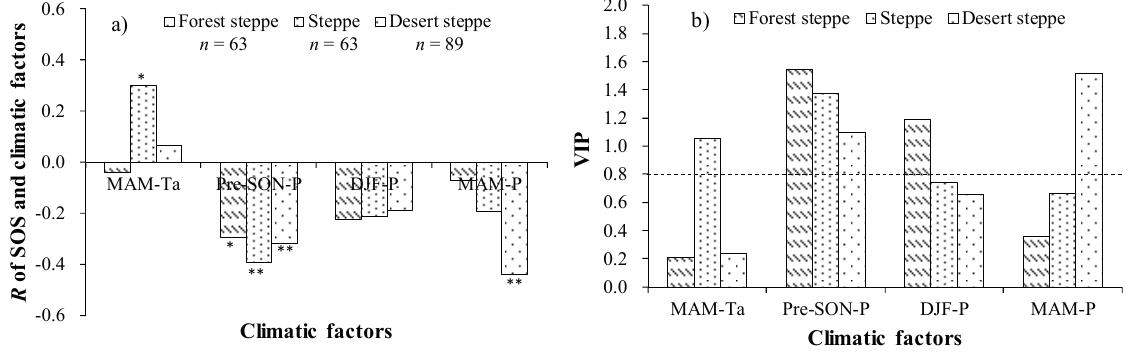
Figure 4. Correlation ( a ) between SOS and climatic factors for three grassland types and VIP ( b ) for considered variables. * indicates the significance level of 0.05 and **